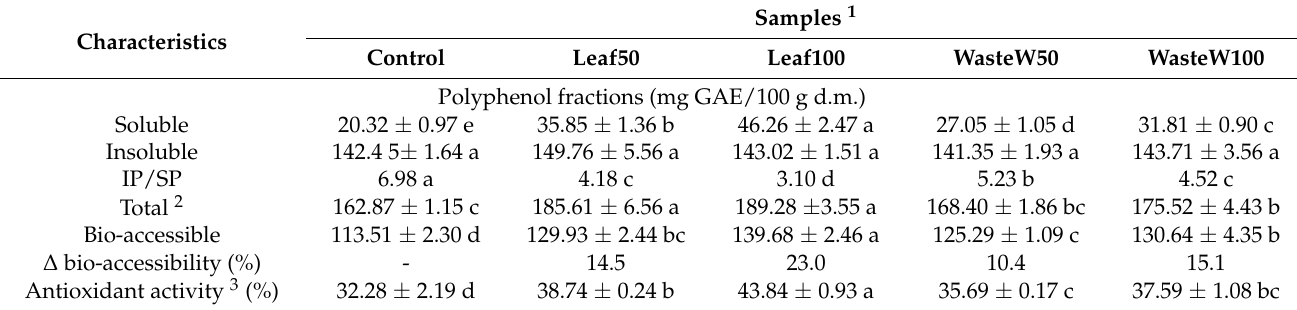
Table 4. Polyphenol fractions and antioxidant activity of GF control and fortified breadsticks.